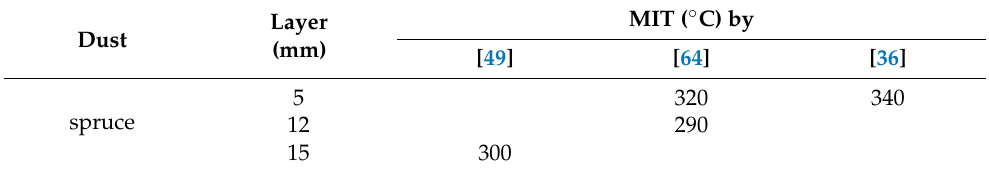
Table 7. Overview of minimum ignition temperatures of flammable dusts according to EN 50281-2-1 [48]. MIT ( ◦ C) by Layer Dust (mm) [49] [64] [36] 5 320 340 spruce 12 290 15